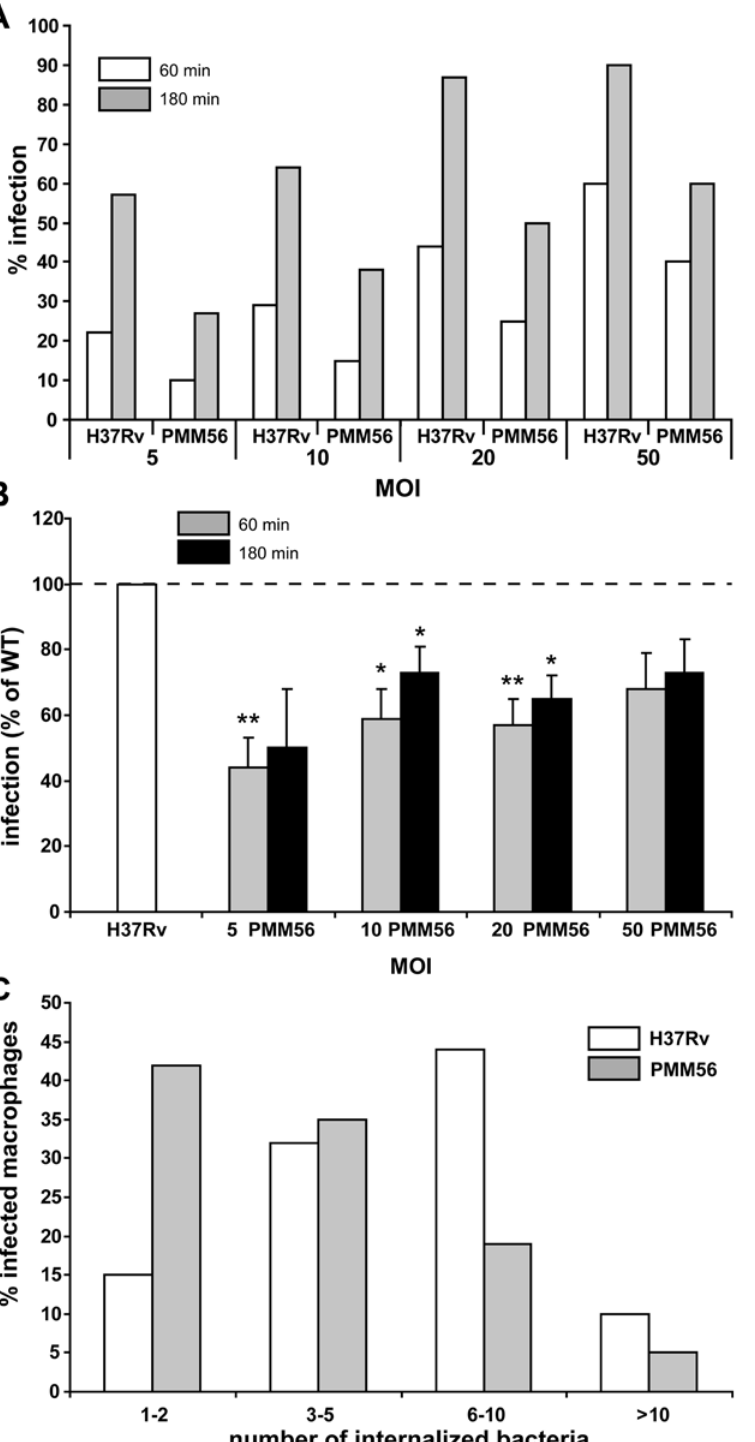
Figure 1. DIM are involved in the infection of human macrophages by Mtb: MDMs were incubated with H37Rv WT or a DIM-less PMM56 mutant and processed for counting by fluorescence microscopy. (A) Percentage of macrophages having ingested at least one bacterium after 60 or 180 minutes of incubation. Data from one experiment performed in duplicate and representative of three independent experiments. (B) Percentage of macrophages infected by the PMM56 mutant expressed with respect to the percentage of macrophages infected with the WT (H37Rv, set at 100%). The values are means 6 SEM of three to five separate experiments performed in duplicate. The significance of differences between the mutant and the WT strain was evaluated: *, p , 0.05; **, p , 0.02. (C) Percentage of infected macrophages after 180 minutes of incubation as a function of the number of ingested WT or the PMM56 mutant. Data from one experiment performed in duplicate and representative of two independent experiments.